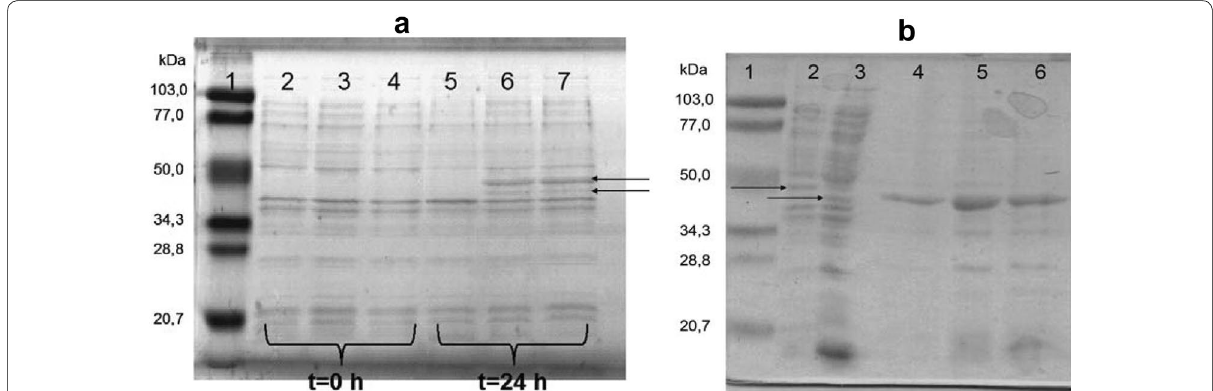
Fig. 5 SDS‑PAGE. a The whole cell protein extracts of two clones during overexpression, where in lane 1: MM marker; lanes 2, 5: BL21(DE3)/pET29c; lanes 3, 6: BL21(DE3)/pET29c:: lip clone a; lanes 4, 7: BL21(DE3)/pET29c:: lip clone b, b lipase purification steps, where in lane 1: MM marker; lane 2: crude protein extract at 24 h induction; lane 3: total soluble protein extract after cell lysis and centrifugation; lane 4: purified lipase LipSm fraction 1; lane 5: purified lipase LipSm fraction 2; lane 6: purified lipase LipSm fraction